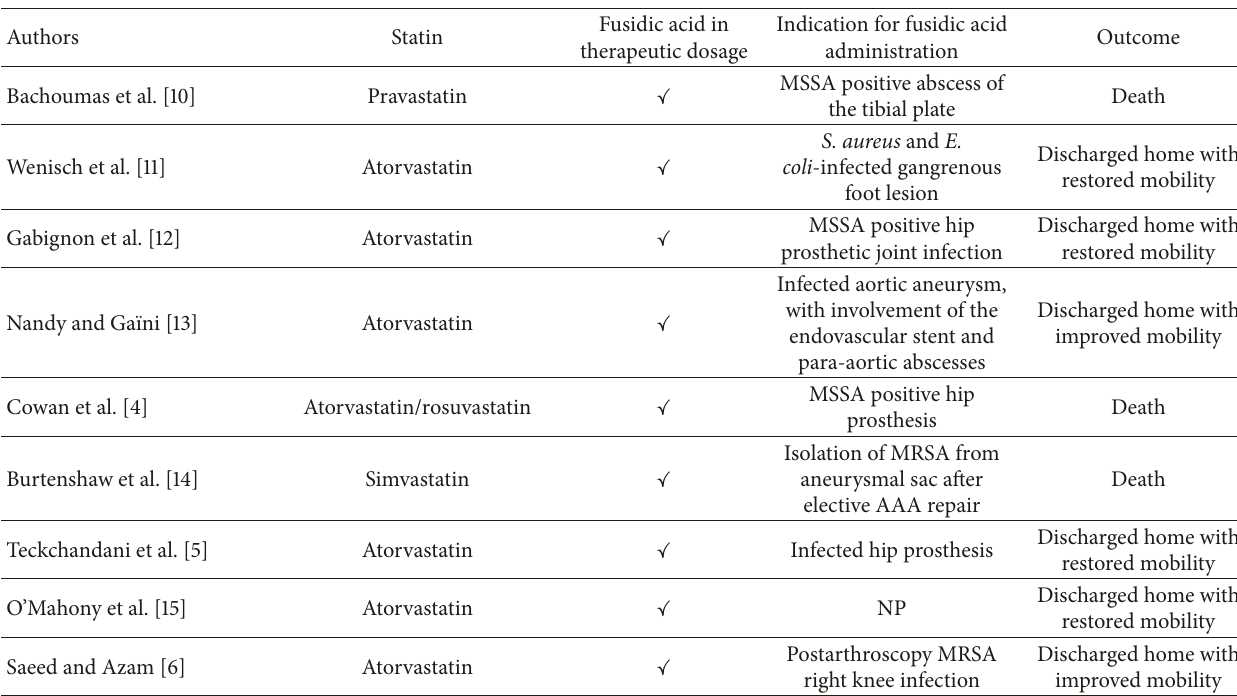
Table 2: Summary of the published case reports highlighting the discussed drug-drug